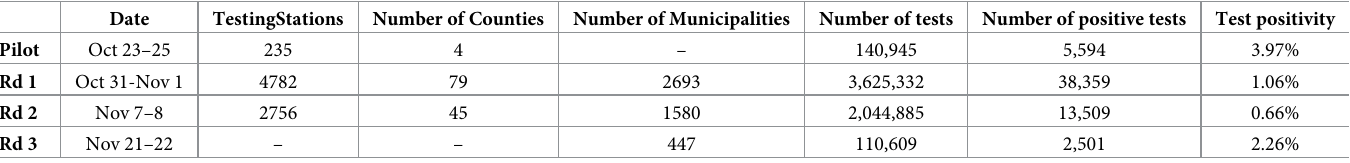
Table 1. Summary of the mass testing in Slovakia (total 79